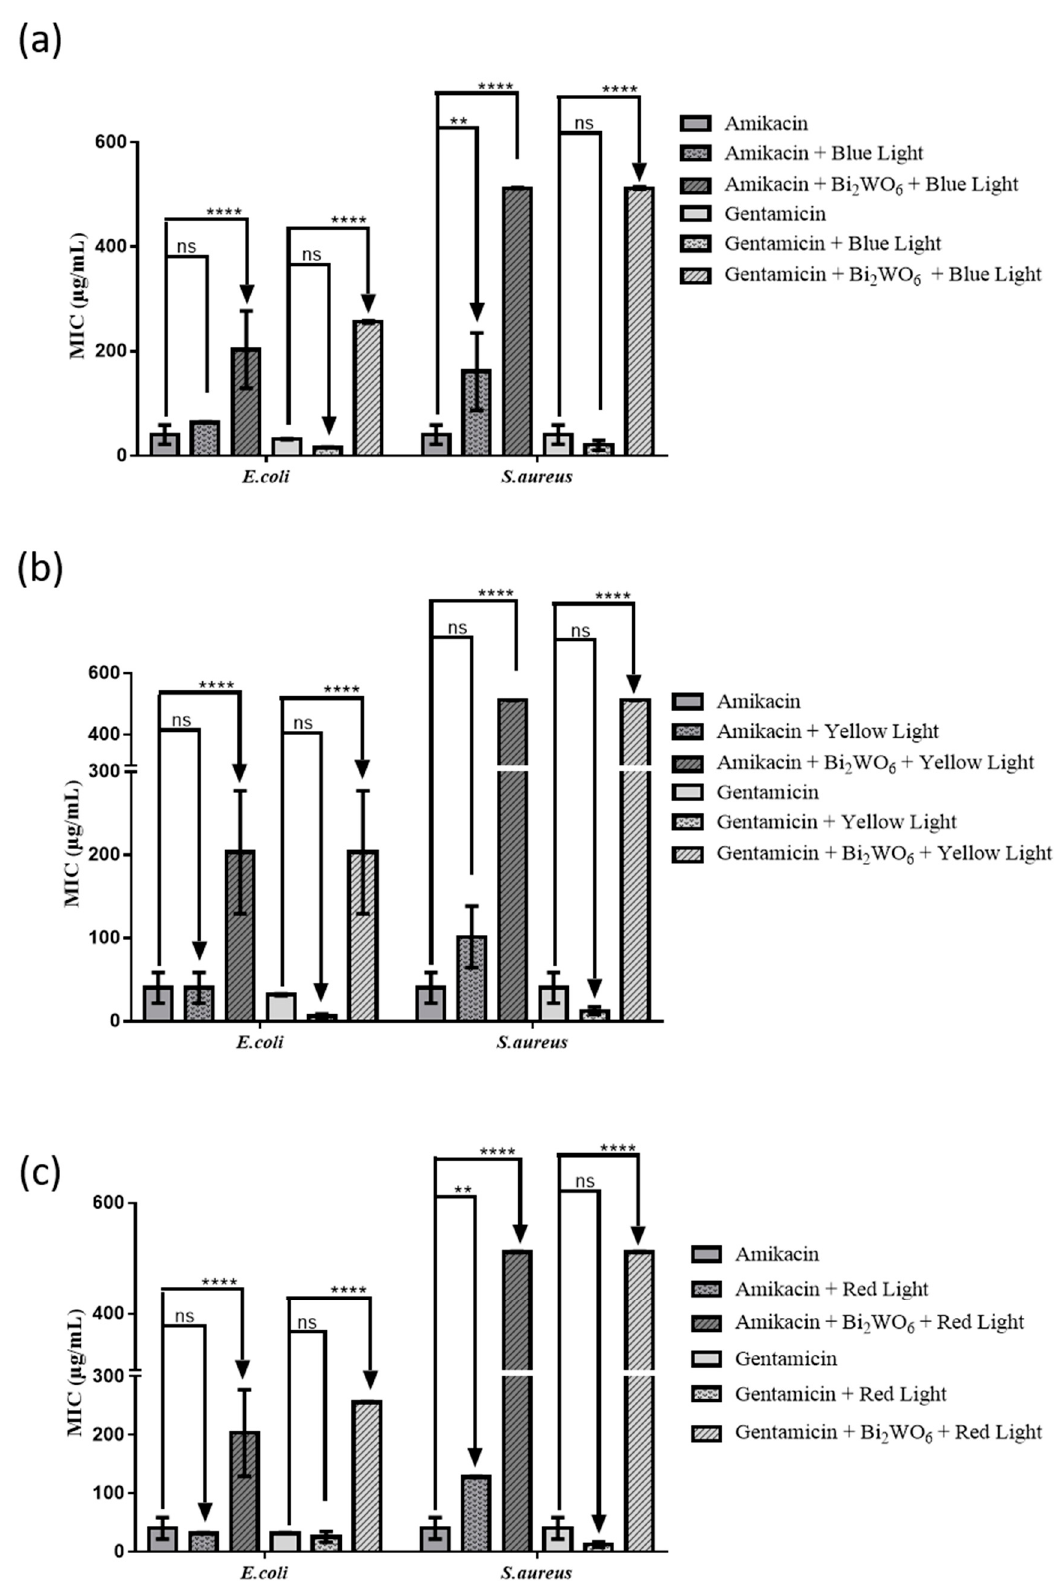
Figure 7. MIC of amikacin and gentamicin alone, or in the presence of Bi 2 WO 6 monolayers and ( a ) blue, ( b ) yellow or ( c ) red LED lights, against MDR S. aureus and E. coli strains. **** p < 0.0001, ** p < 0.01, ns: value statistically